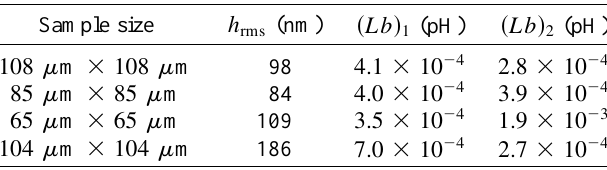
TABLE II. Product Lb for larger samples.